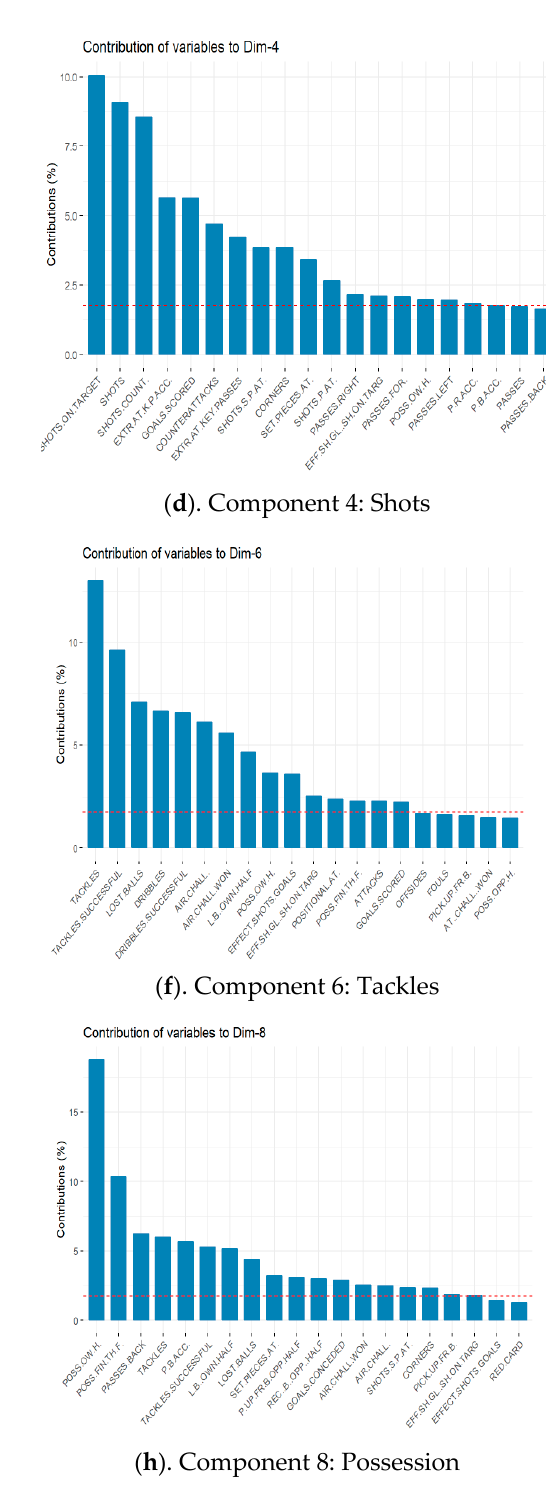
Figure 2. Components and new subjective variables of best teams. ( a ): Passes; ( b ): Challenges; ( c ): Attack effectiveness; ( d ): Shots; ( e ): Dribbles; ( f ): Tackles; ( g ): Offensive transitions; ( h ): Possession.